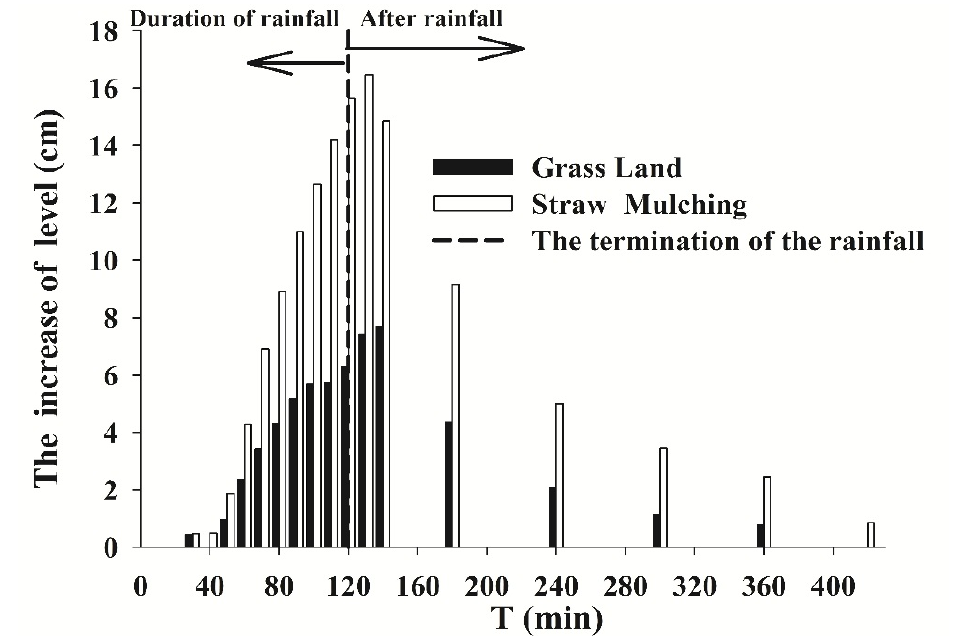
Figure 17. Time-series graphs of the groundwater level increase with underlying surface